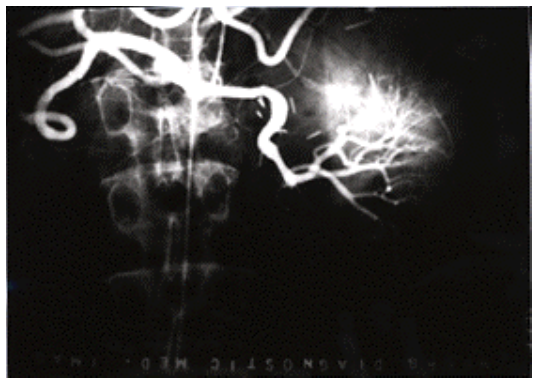
FIGURE 1b . Preoperative angiogram showing high grade left renal artery ostial stenosis